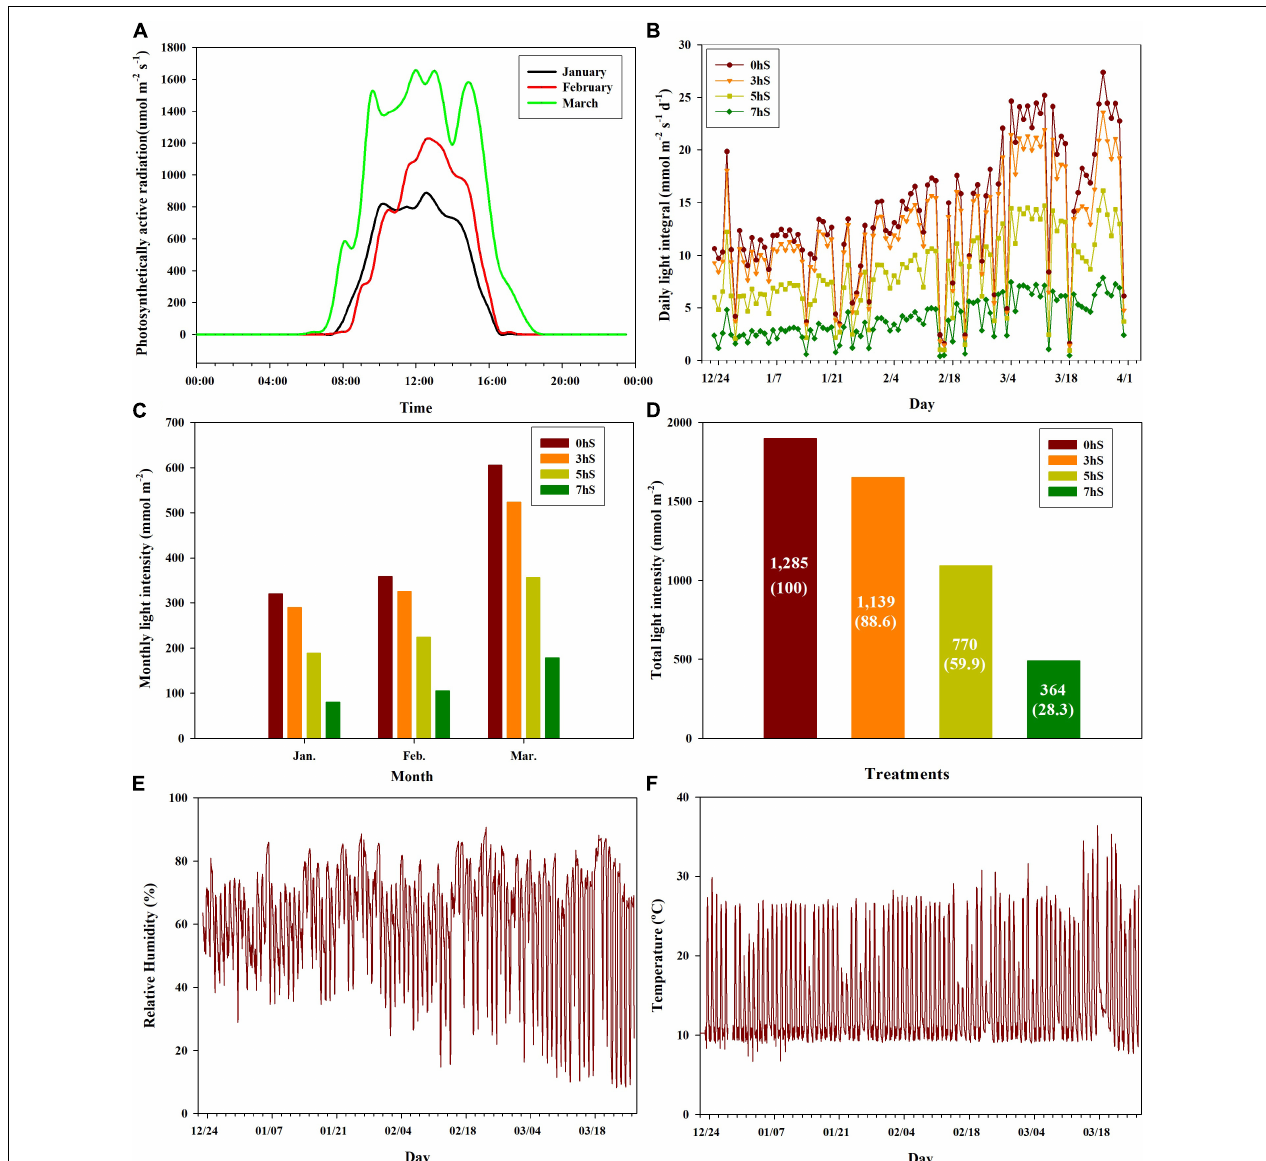
FIGURE 1 | Ambient light intensities under different shading treatments and aerial environmental conditions in a smart greenhouse used for strawberry ( Fragaria × ananassa ) cultivation. (A) distribution of light intensity on sunny days by month; (B) daily light integral by month; (C) monthly light intensity; (D) total light intensity during the experimental period; (E) relative humidity inside the smart greenhouse from January to March 2019; (F) temperature inside the smart greenhouse from January to March 2019. 0 hS, non-shading treatment (control); 3 hS, three hours of shading until 10:00; 5 hS, five hours of shading until 12:00; 7 hS, seven hours of shading until